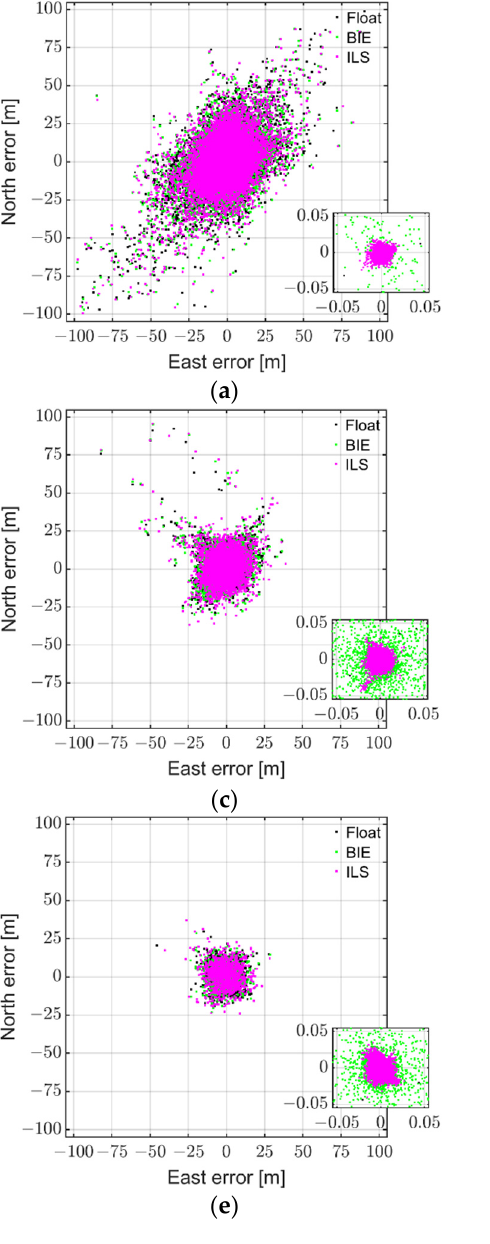
Figure 4. Horizontal (north/east) scatter plot of the multi-GNSS, dual-frequency (L1 + L5 GPS, E1 + E5a Galileo, L1 + L5 QZSS, and B1 BDS) GP4 data derived with the BIE ( green dots ), ILS ( magenta dots ), and ambiguity float ( black dots ) estimators for instantaneous RTK positioning with smartphone internal antennas for a short baseline in Dunedin, New Zealand, based on 6 h of data (1 s measurement interval): ( a ) 9.6% ILS SR (40° cut-off); ( b ) 53.9% ILS SR (30° cut-off); ( c ) 72.1% ILS SR (25° cut-off); ( d ) 84.0% ILS SR (20° cut-off); ( e ) 91.9% ILS SR (15° cut-off); ( f ) 95.4% ILS SR (10° cut-off).